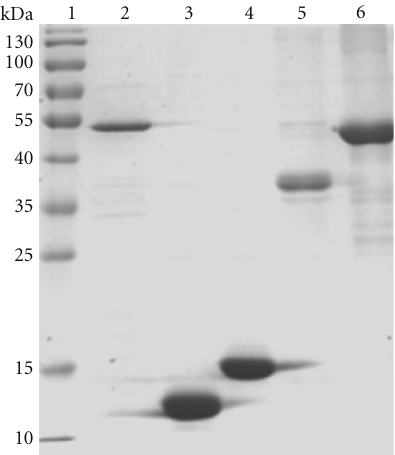
Figure 1: SDS-PAGE analysis of purified RD5-encoded recom- binant proteins. Lane 1, molecular weight markers (SM0671, Fermentas, USA). Lane 2–6, purified Rv3117–Rv3121 recombi- nant proteins; molecular weight is 48.1 kDa, 11.2kDa, 16.9 kDa, 38.2 kDa, and 45.3kDa, respectively. Proteins were visualized with Coomassie brilliant blue